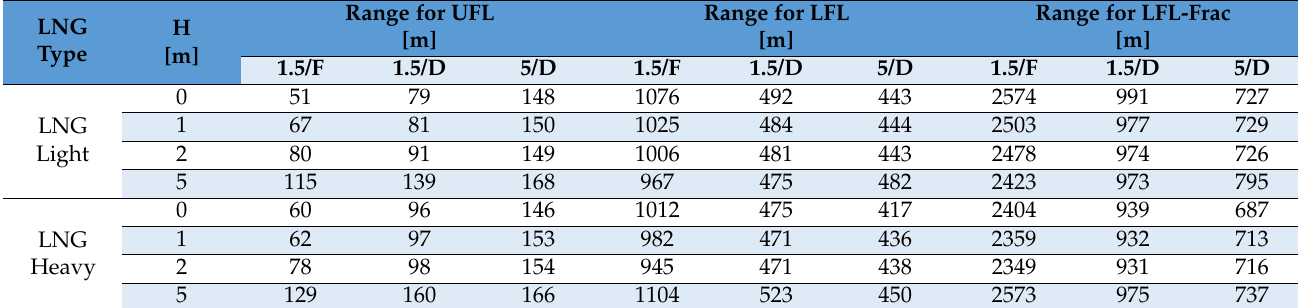
Table 7. Dispersion, leak,